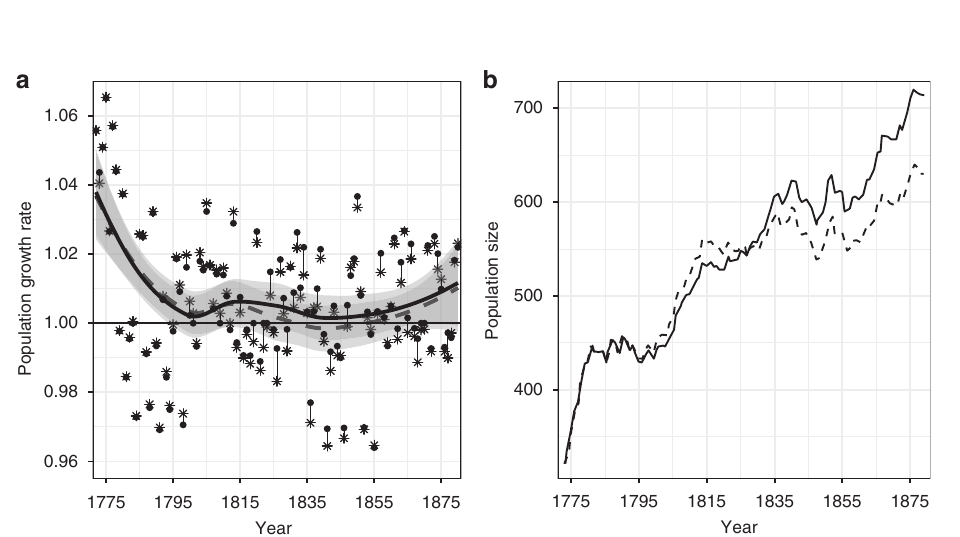
Figure 2 | Population dynamics of the ıˆ le aux Coudres population from 1772 to 1880. In a solid circles and full line represent the yearly population growth rates ( N t þ 1 / N t ) calculated from the Register, while asterisks and the dashed line represent an approximation of the predicted growth rates, in the absence of evolution. The two lines were fitted using loess and are accompanied by their 95% CI (grey areas around the lines). In b the full line represents the population size calculated from the Register, whereas dashed line represents population size estimated from the model in absence of